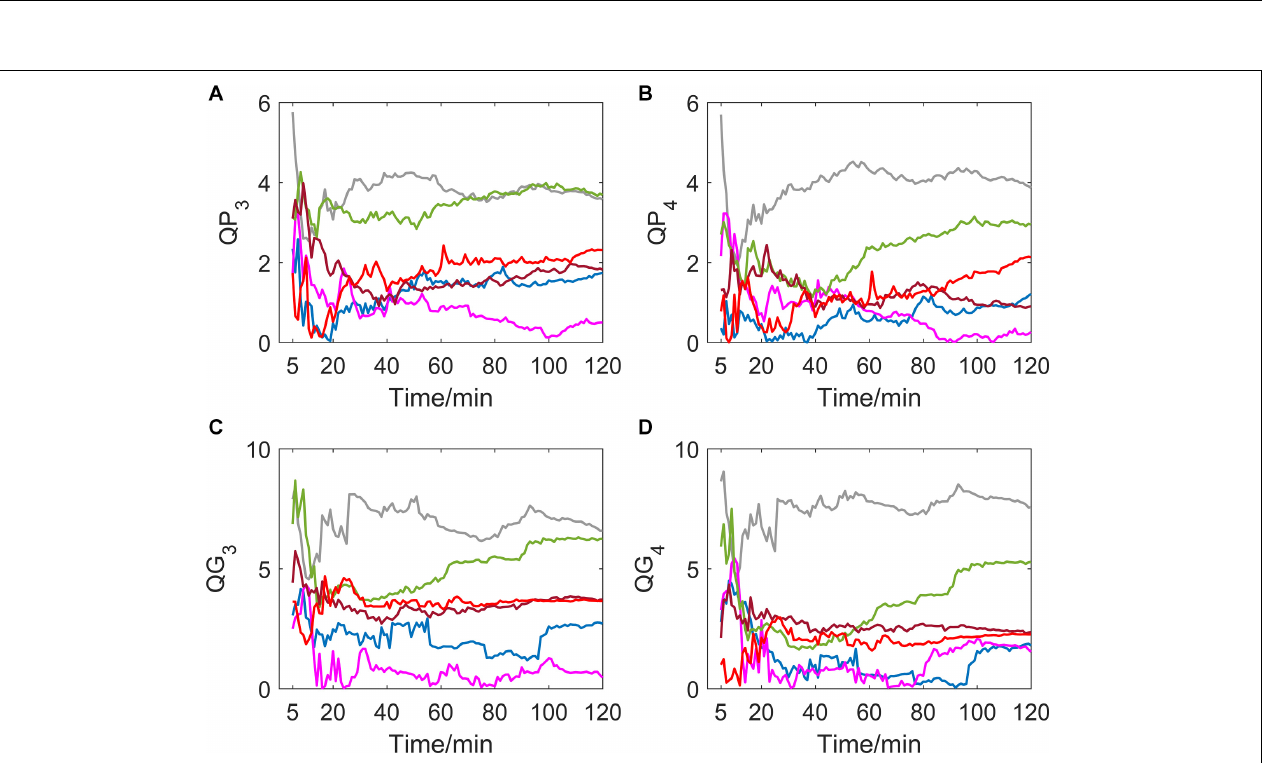
FIGURE 5 | (A–D) show the corresponding results of QP 3 , QP 4 , QG 3 , and QG 4 . Variation tendency of QP 3 , QP 4 , QG 3 , and QG 4 within 2 h of MIT normoxic group.